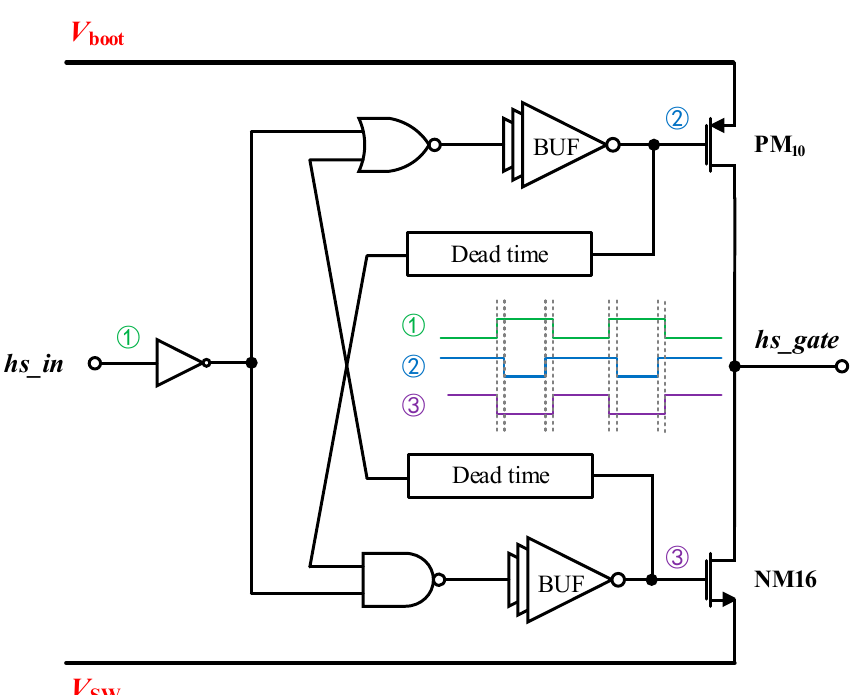
Figure 5. Circuit realization of ( a ) level-up shifter and ( b ) level-down shifter employed in proposed structure.